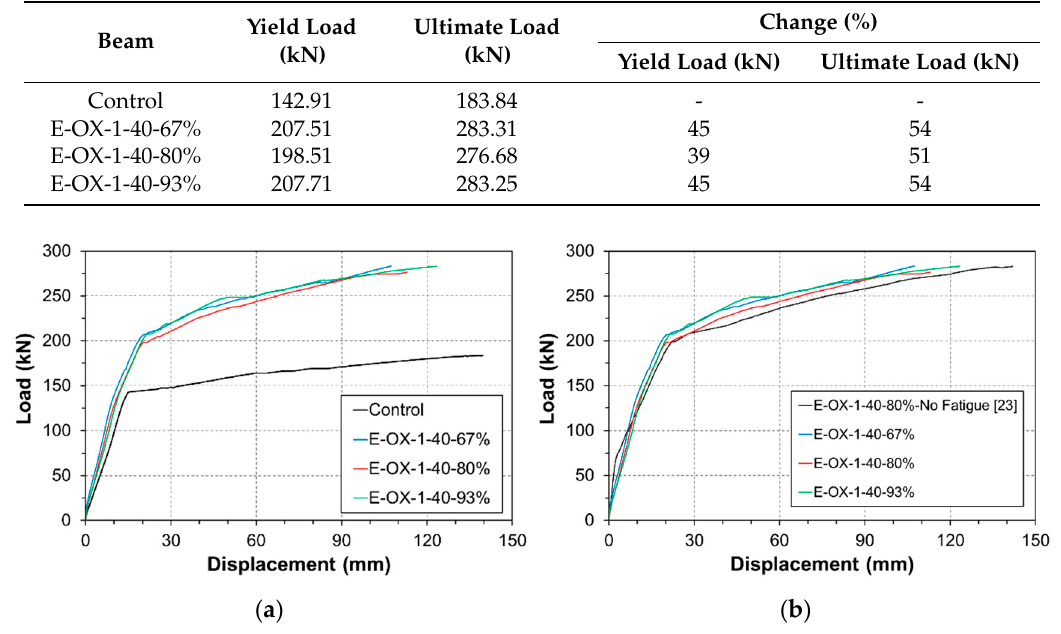
Figure 12. Load-displacement relationships (Bond length): ( a ) vs. control; ( b ) vs. no fatigue.